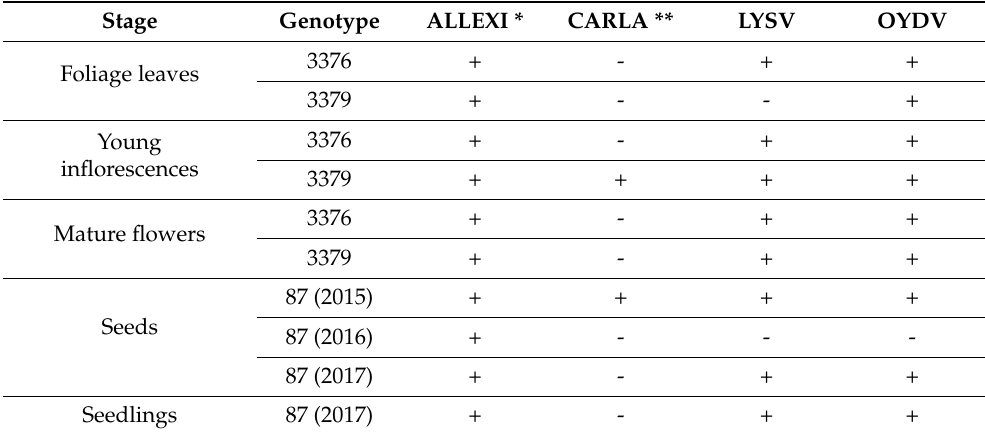
Table 2. PCR analysis of garlic viruses in organs and tissues of clonally propagated fertile garlic genotypes, seeds, and seedlings.